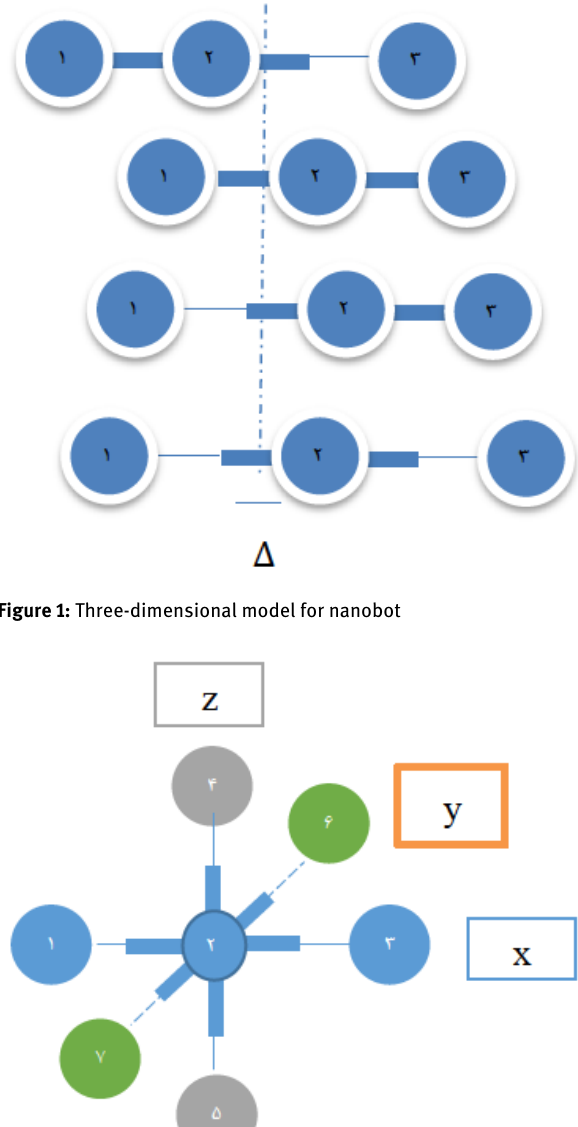
spheres being added perpendicularly to the central sphere along y and z axes, this model can be used as a practical modelformovingnanobots.Thismodelcontains7spheres and 6 arms (figure 2). Imagine a cube that at the middle of each square face of that there is a sphere; therefor the cen- tral sphere will be in the center of cube where its diame-